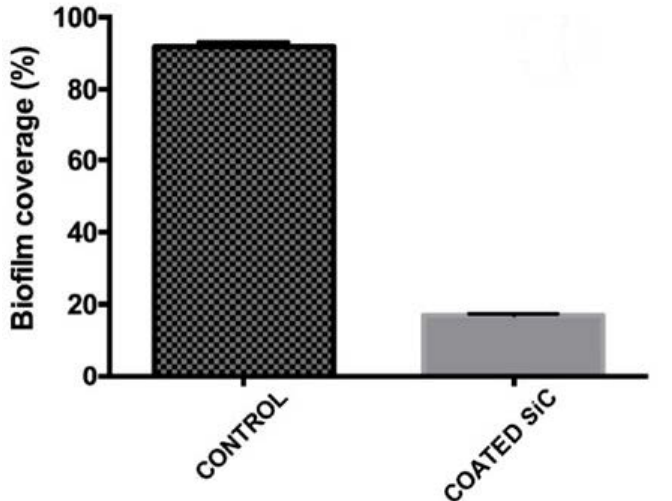
Figure 16. ( a ) Live coverage of Streptococcus mutans and Streptococcus sanguinis after 24 h of culture on the non-coated (control) and SiC-coated surfaces [48].